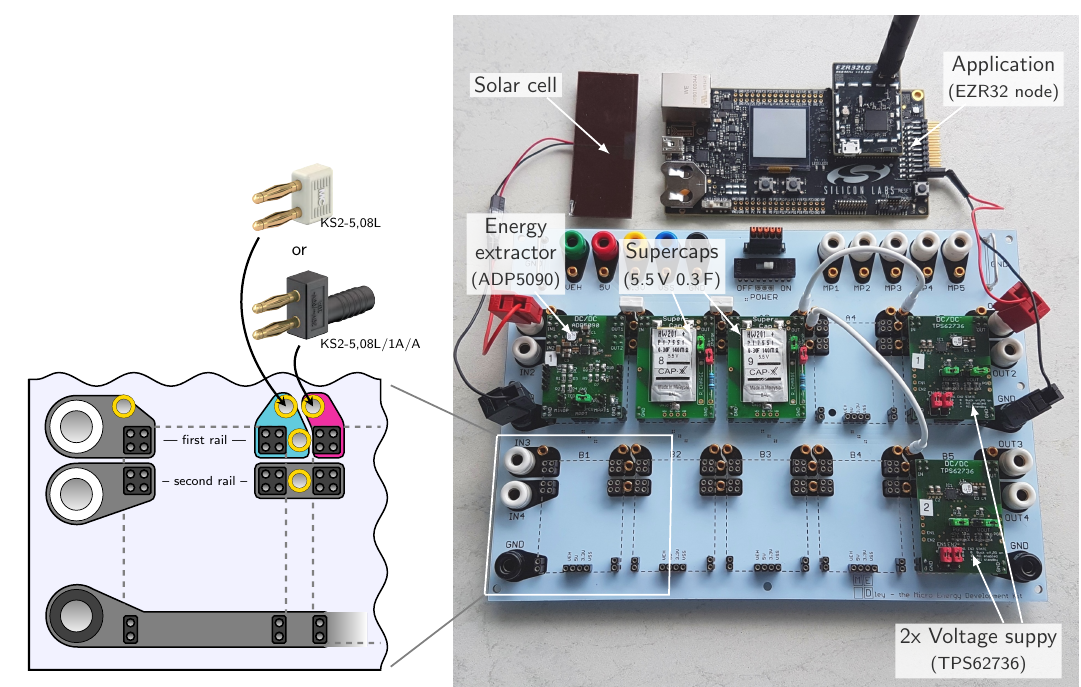
Figure 5. Photo of Medlay with an example setup. Energy from a solar cell is extracted by the ADP5090 and stored on a supercapacitor array. A regulated voltage (3.3 V and 3.6 V) is provided by two